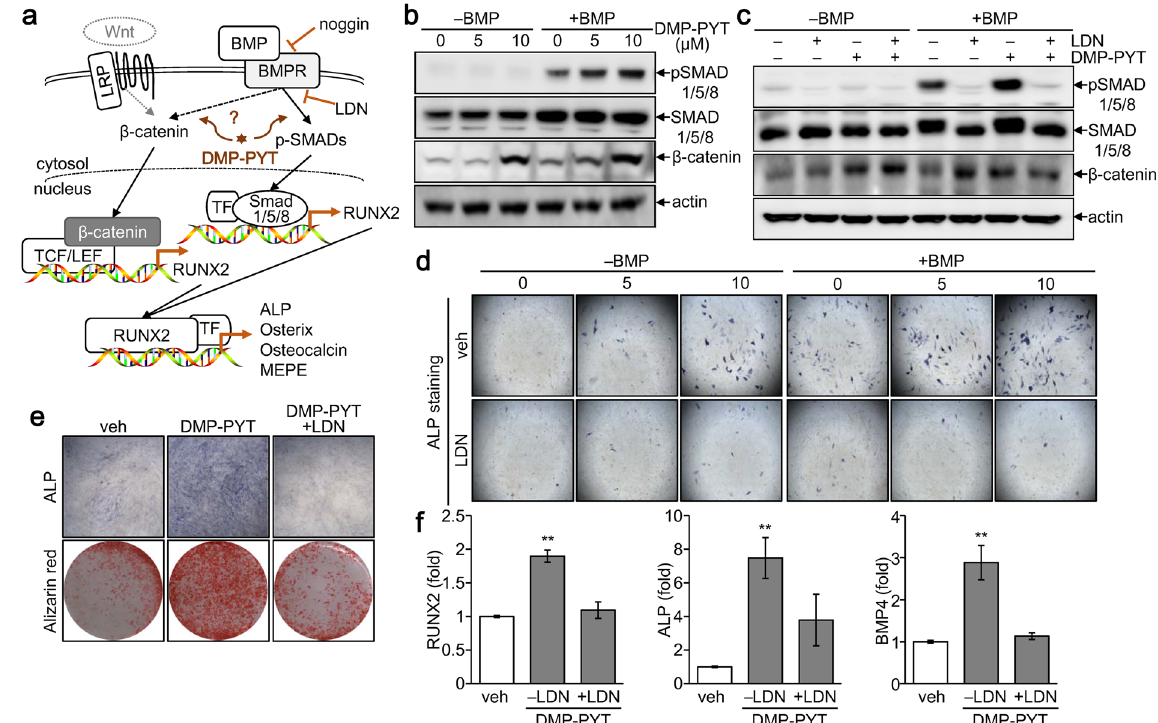
Figure 4. Enhanced BMP signaling by DMP-PYT during osteoblast differentiation. ( a ) A schematic diagram showing BMP-mediated signaling cascade. ( b ) C2C12 cells were plated and treated with DMP-PYT (5 and 10 µ M) for 30 min in the absence or presence of BMP2 (25 ng/ml). Total protein lysates were harvested and analyzed by SDS-PAGE and immunoblotting with antibodies against pSMAD, SMAD, β -catenin, and β -actin. ( c ) Separately, cells were incubated with DMP-PYT (10 µ M) for 30 min in the absence or presence of the BMP inhibitor, LDN-193189 (100 nM) and BMP2 (25 ng/ml). Total protein lysates were freshly harvested